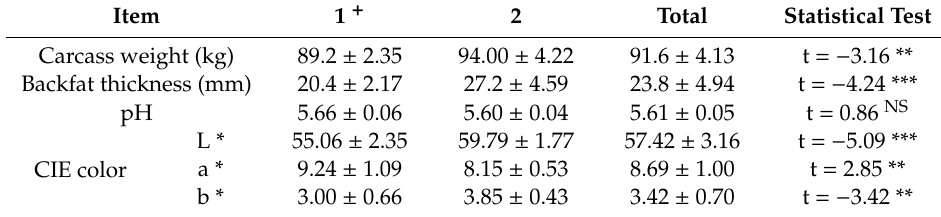
Table S1. For transcriptomic analysis, 20 samples of loin muscles were immediately frozen in liquid ◦ nitrogen and stored at − 80 C until RNA extraction. Table 1. Basic characteristics of the study subjects by